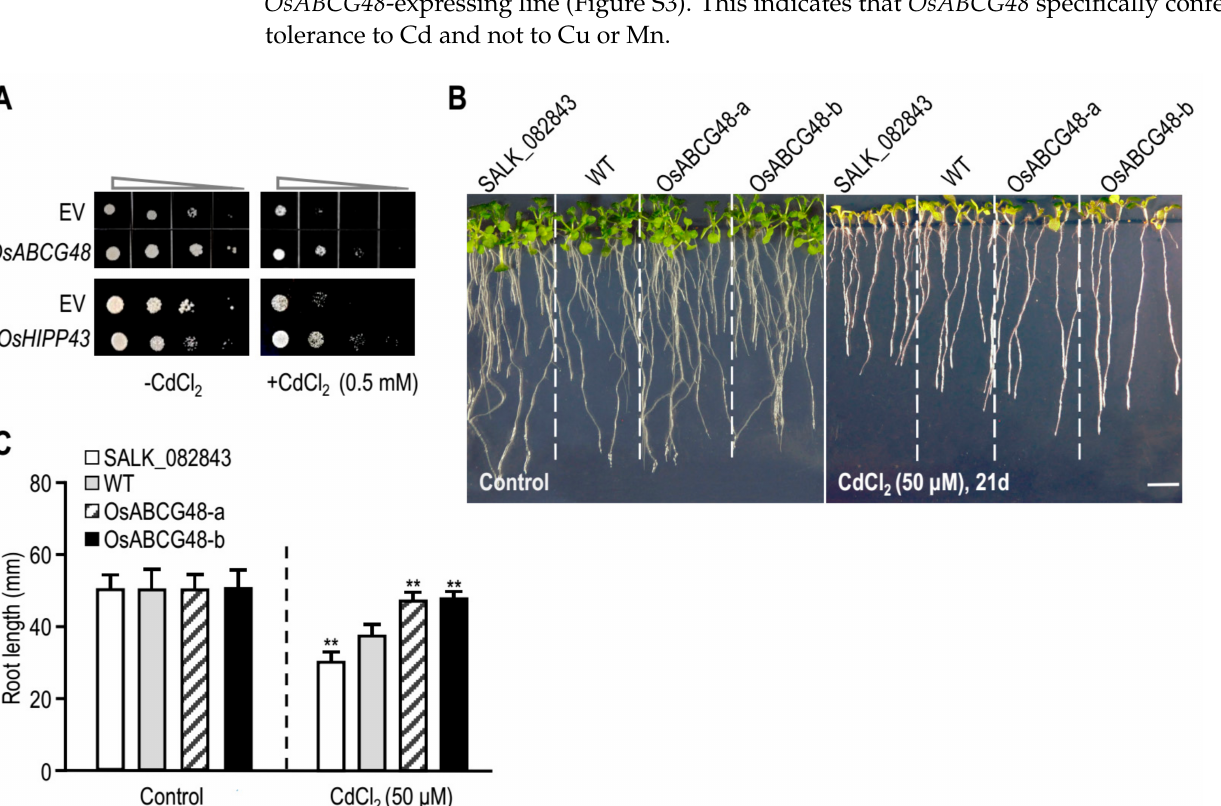
Figure 3. Expression of OsABCG48 confers tolerance to Cd in S. pombe and Arabidopsis . ( A ) Dilution (10-fold) bioassay of S. pombe strains on EMM + uracil agar plates without or with CdCl 2 (0.5 mM); EV is empty vector control. ( B ) Cd tolerance assay of OsABCG48 expression lines of Arabidopsis . ( C ) Root length recorded from 21-day-old seedlings germinated and grown in medium without or with 50 µ M CdCl 2 . Figure 3B is from a representative experiment among three with similar results. Atabcg34 T-DNA knockout line (SALK_082843) used as negative control. Data (bar and error bar) are shown as mean ± SD ( n = 13 to 19); statistical analysis by unpaired Student’s t -test compared to WT (** p < 0.01); scale bar = 1